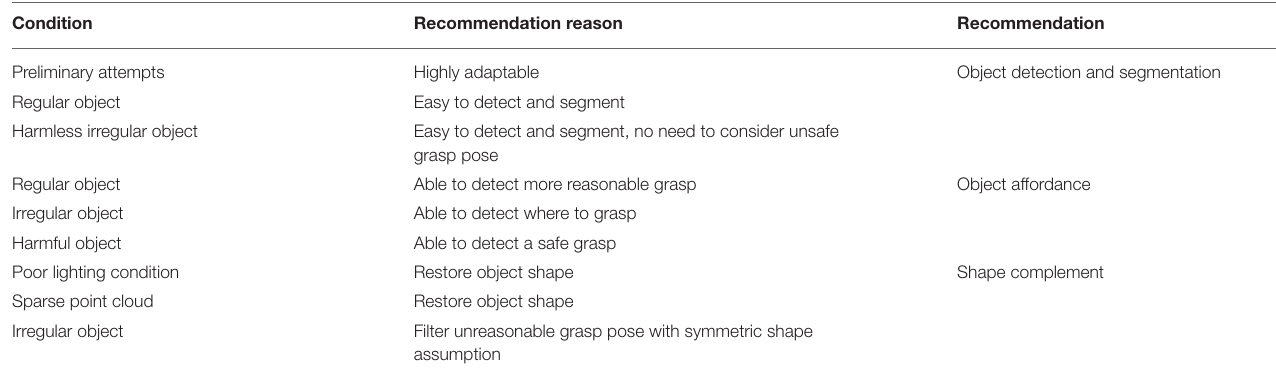
TABLE 4 | Object-aware sampling branches